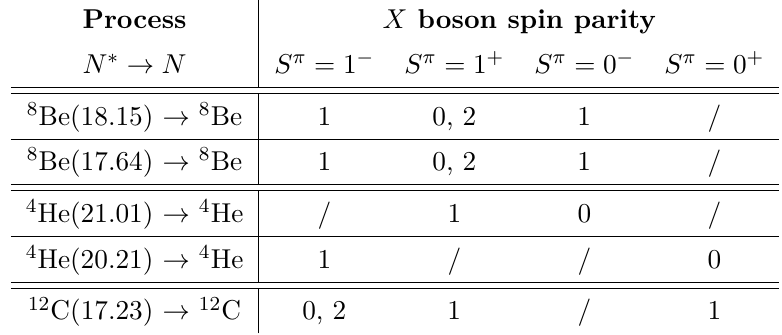
Table 2 . Relative angular momentum between the X boson and N in the various decays, based on its possible parity-spin assignments. Note that parity conservation prohibits a pure scalar solution to the Beryllium